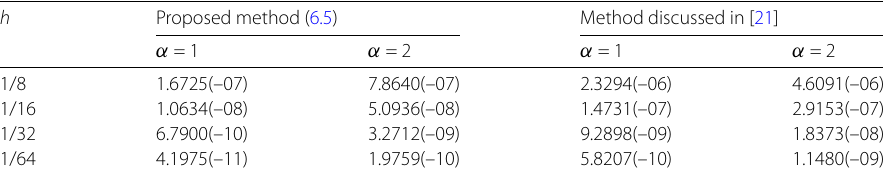
Table 2 Problem 8.2: The maximum absolute errors h Proposed method (6.5)